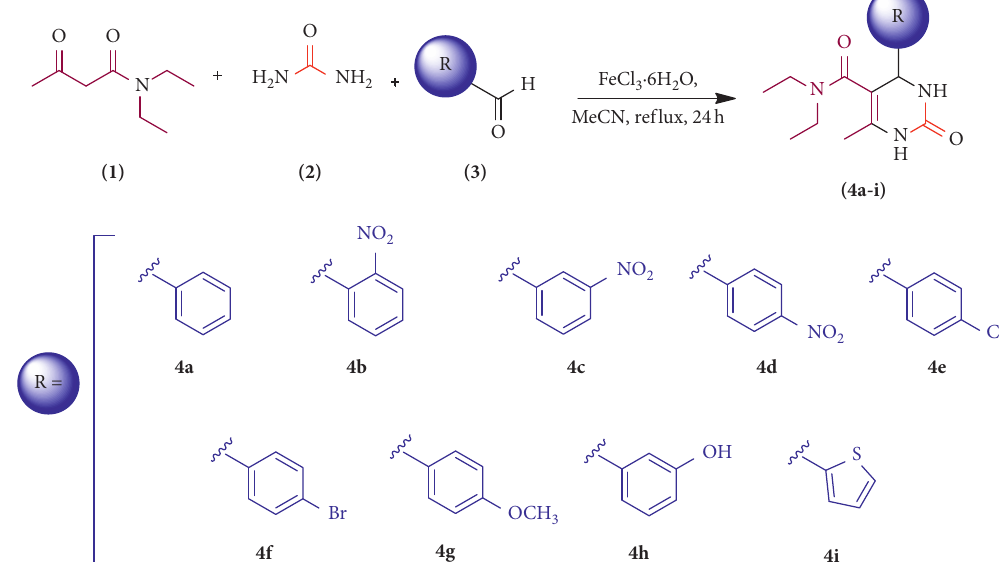
Scheme 1: Synthetic routes to the dihydropyrimidinone series ( 4a – i ).